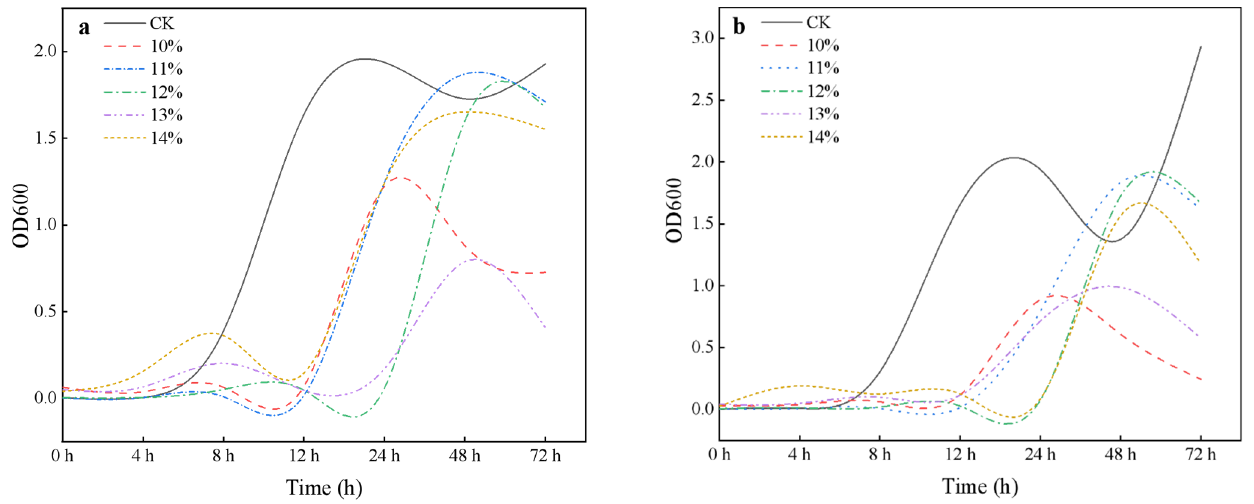
Figure 1. Growth curves of NX-3 ( a ) and NX-4 ( b ) strains under varying salt concentrations (10%, 11%, 12%, 13%, and 14% NaCl).